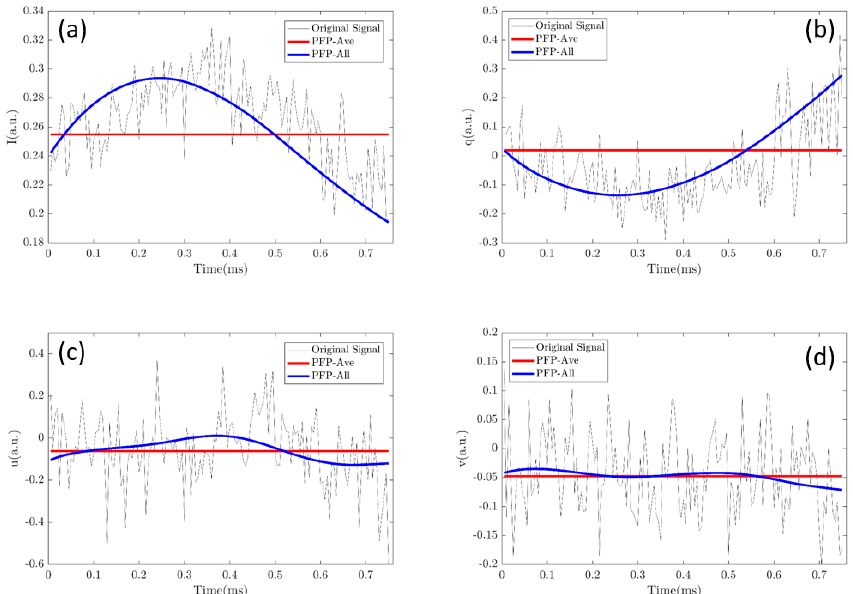
Figure 8. Temporal values of a polarized light pulse processed by the PLP-All method and the dash line is the value given by the PLP-Ave method: ( a ) Intensity values (I); ( b ) polarization parameter (q); ( c ) polarization parameter (u); ( d ) polarization parameter (v). ( c ) polarization parameter (u); ( d ) polarization parameter